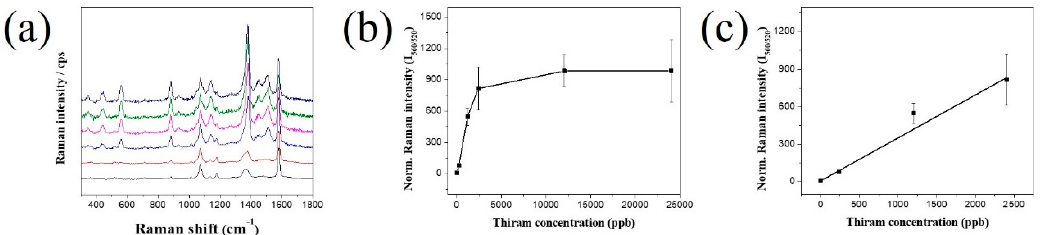
Figure 5. ( a ) Raman signal (different lines from bottom to top represents different thiram concentration: 0, 240, 1200, 2400, 12,000 and 24,000 ppb) and ( b ) Raman intensity ratio at 560 and 520 cm − 1 and ( c ) calibration curves of thiram-incubated SiO 2 @Au@4-MBA@Ag NPs at various concentrations of thiram from 0 to 24,000 ppb. The dynamic linear range of 240 to 2400 ppb with the limit of detection of 72 ppb. Error bar represents an average value of five